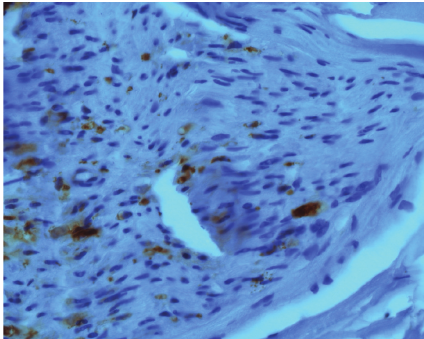
Figure 2: Vasculitis: CD68 immunoreactive macrophages within the epineurium. (Semithin toluidine blue section, × 40 oil immer-